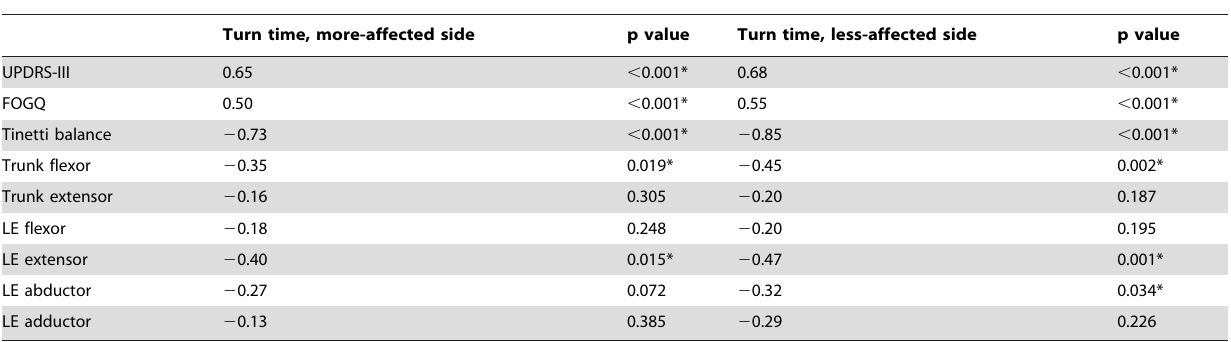
Table 2. Correlation coefficients between turn time and factors.